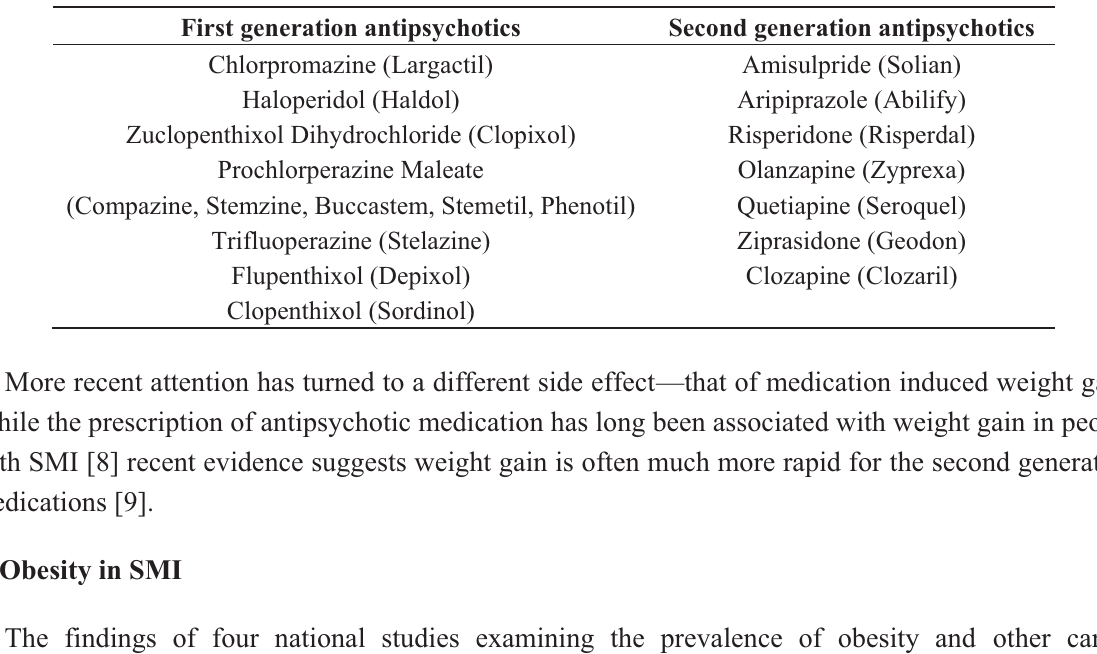
Table 1. Commonly used antipsychotic drugs (trade